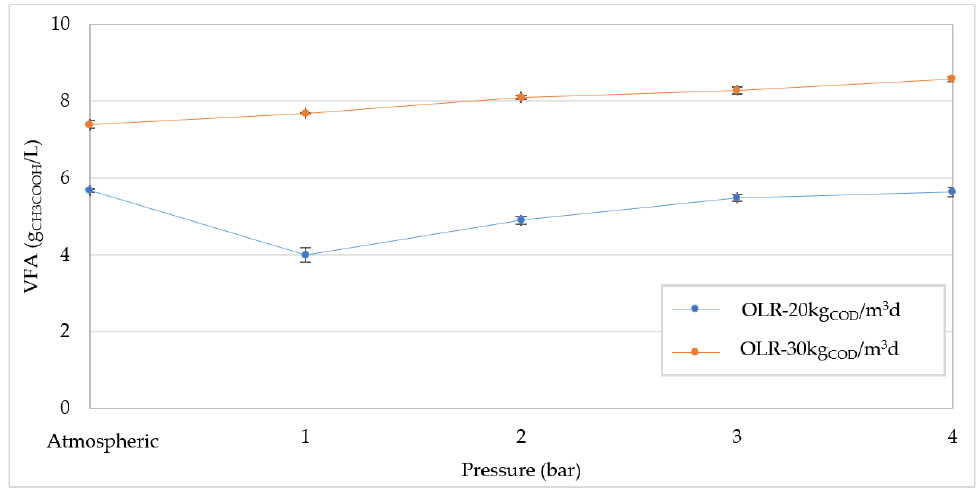
Figure 9. Volatile fatty acids ( VFA) trends at increasing pressures for organic load rate (OLR) of 20 kg COD /m 3 d and 30 kg COD /m 3 d.